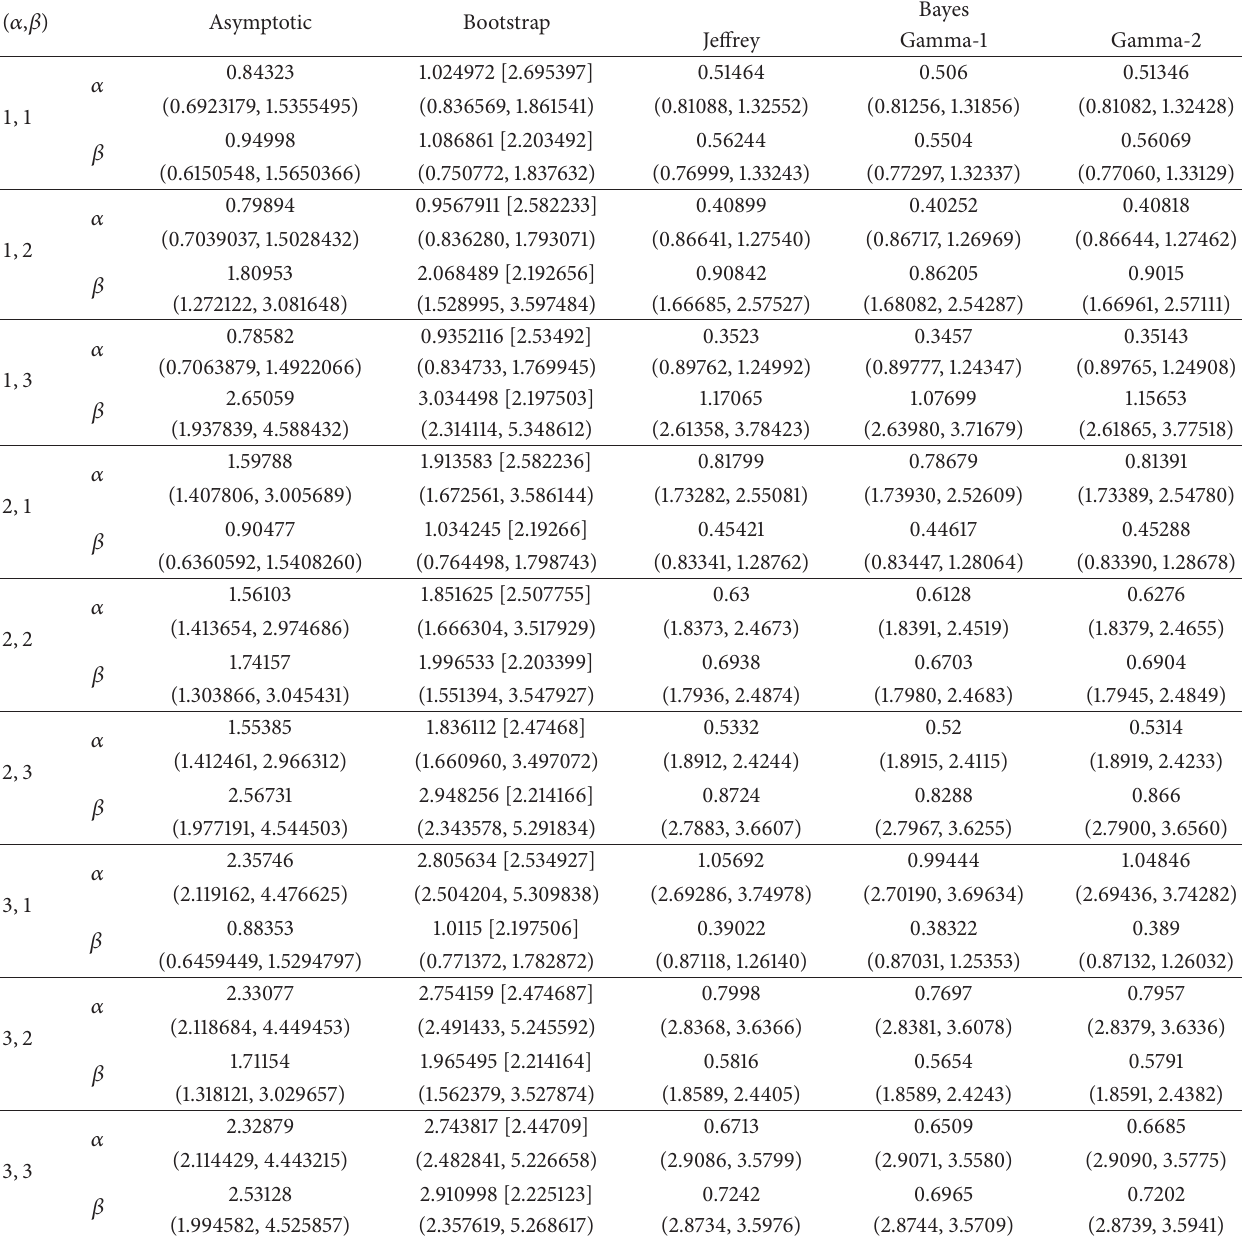
Table 6: Average 95% confidence/HPD intervals (in brackets) and bootstrap method along with their width and shape (in square brackets) for bootstrap method for complete sample 𝑛 = 20 with varying